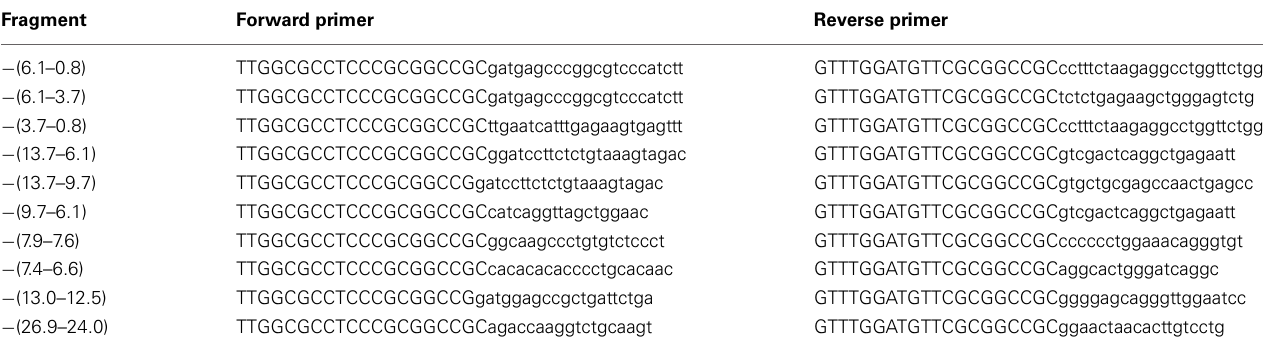
Table 1 | Primer sequences used for In-Fusion